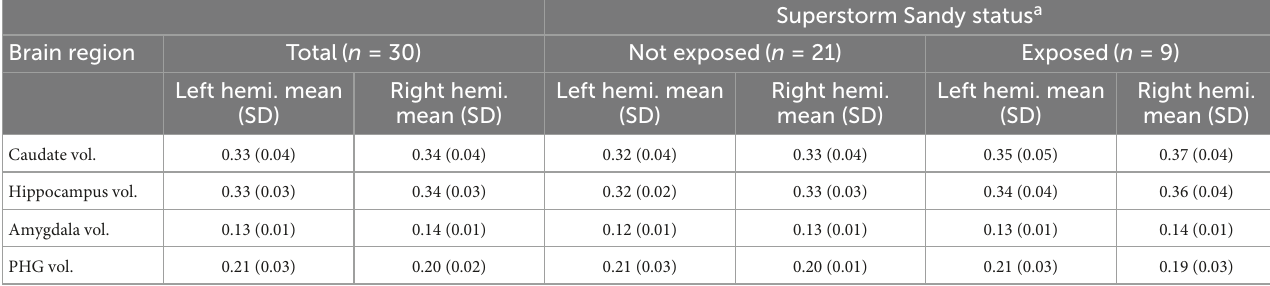
TABLE 2 Mean gray matter volume of brain regions associated with Superstorm Sandy